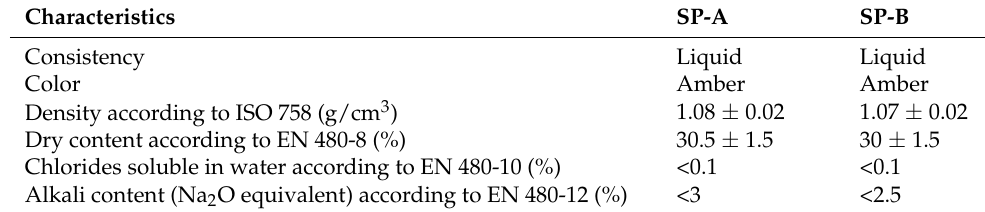
Table 3. Characteristics of